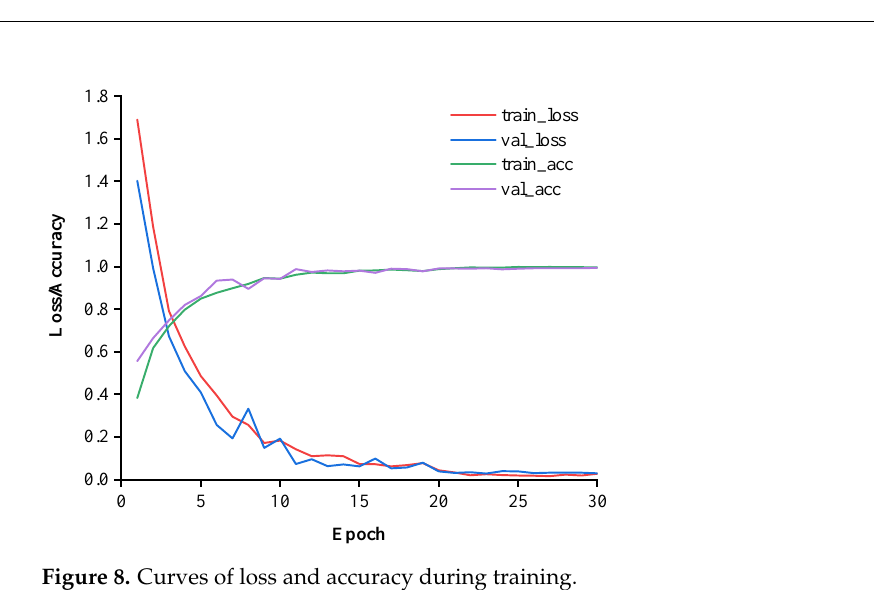
Figure 8. Curves of loss and accuracy during training.